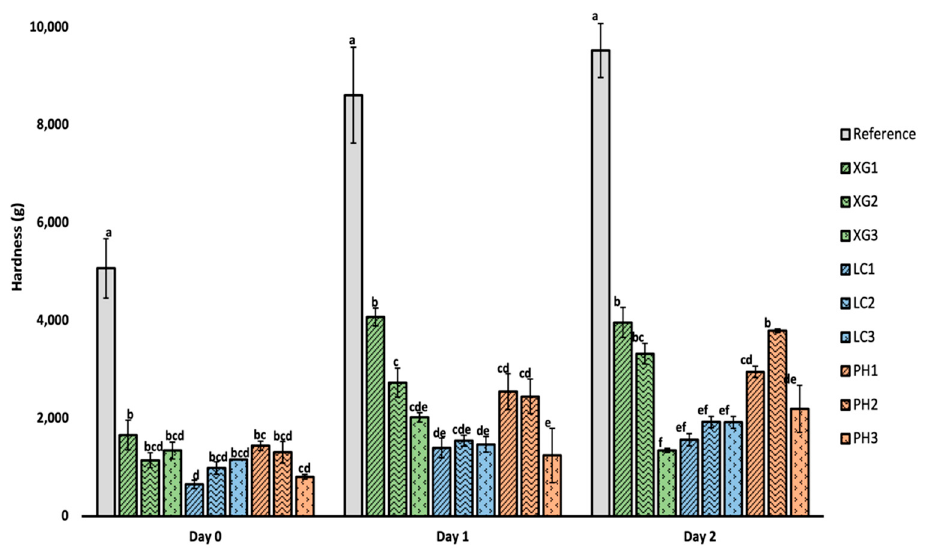
Figure 4. Hardness of bread at day 0, 1 and 2 storage duration at room temperature (~25 °C) obtained by compression test. Error bar represents mean ± standard deviation, n = 3. Different letters represent a significant difference ( p < 0.05) within each storage duration (i.e., Day 0, 1, 2).